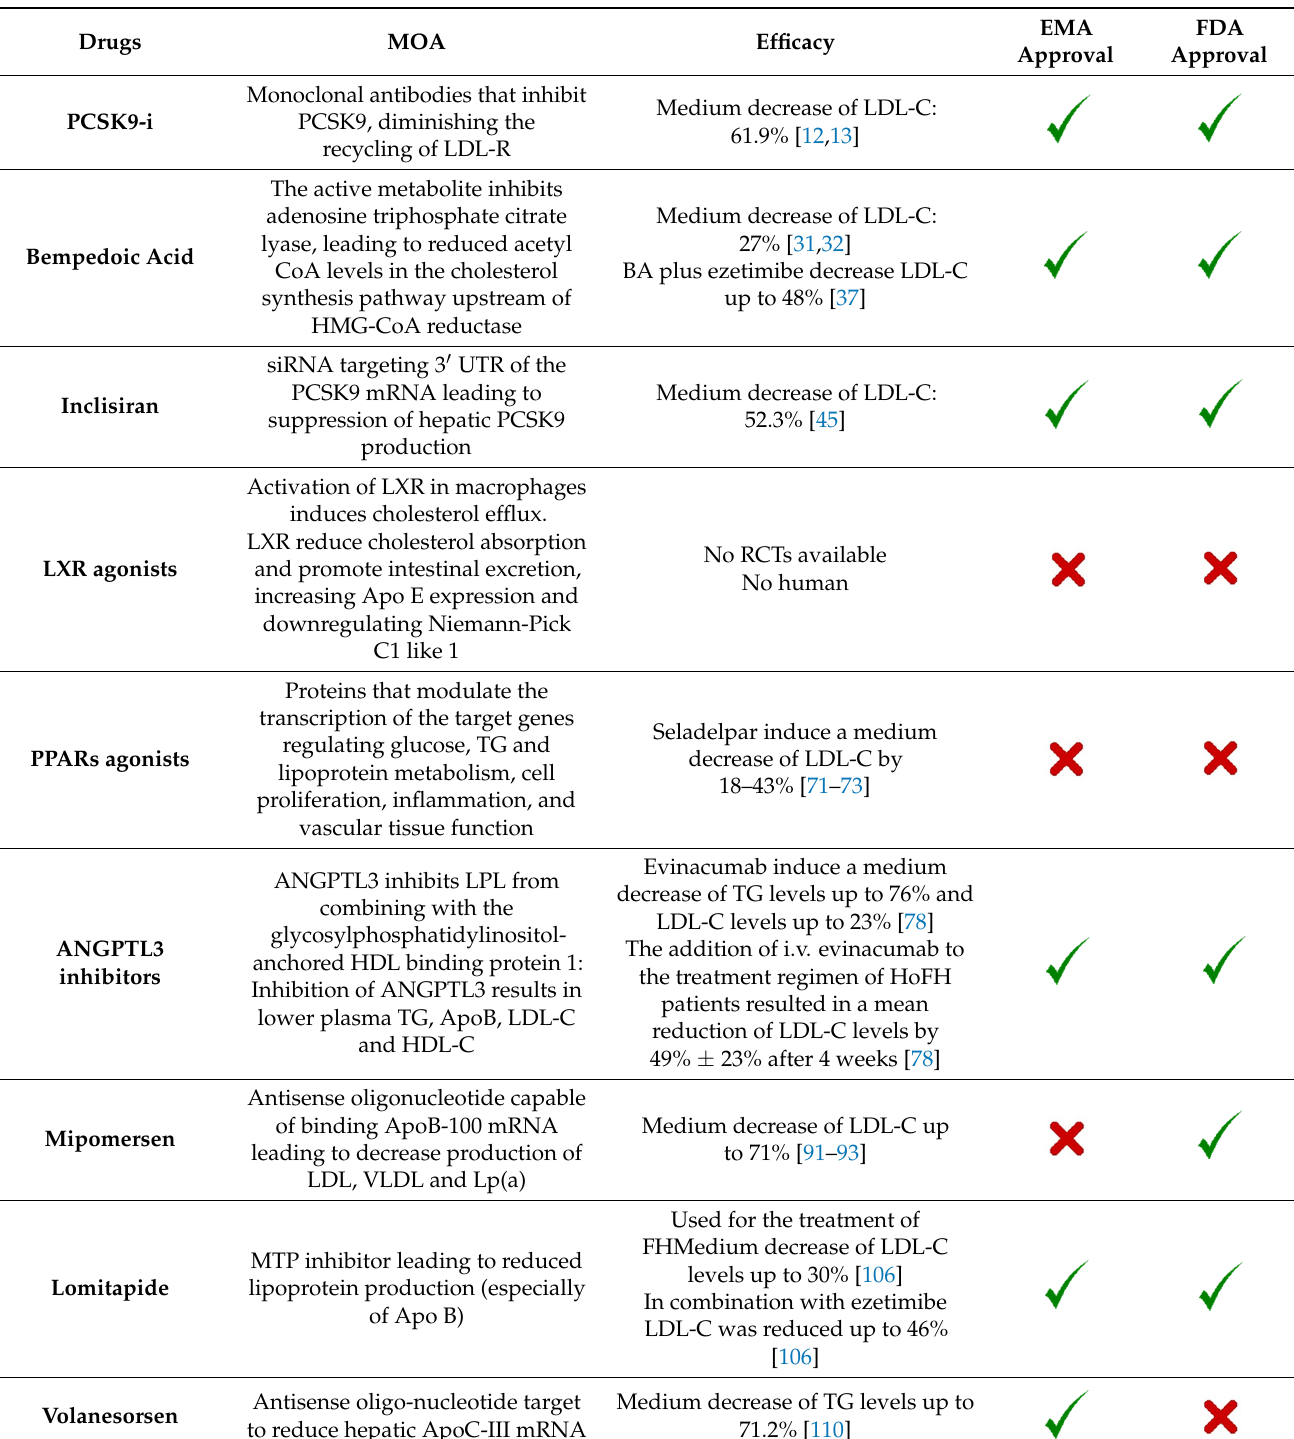
Table 1. Summary of the MOA, main results, and EMA/FDA approval of the novel Lipid Lowering agents.